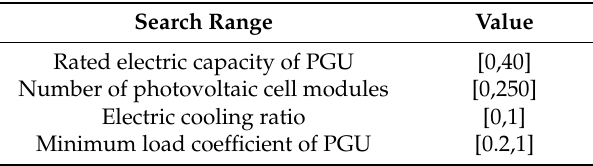
Table 10. Search